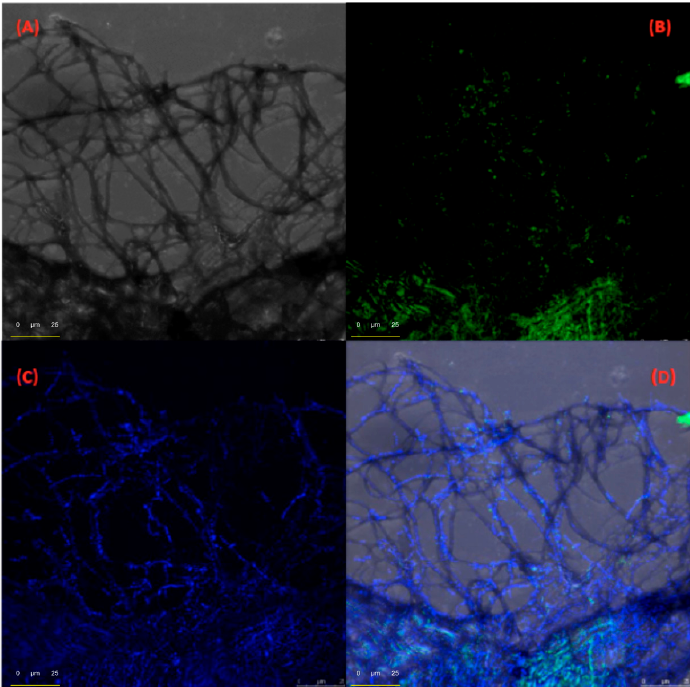
Figure 3. Optical and confocal microphotographs showing microfibres assembled between FeNP-BDI-DA (green) and DB[ah]A (blue) in aqueous media: ( A ) Transmitted light micrograph. ( B ) Fluorescent micrograph λ exc = 448 nm, λ em = 517 nm (FeNP-BDI-DA). ( C ) Fluorescent micrograph λ exc = 405 nm, λ em = 454 nm (DB[ah]A). ( D ) Micrograph Composition of A, B, C.